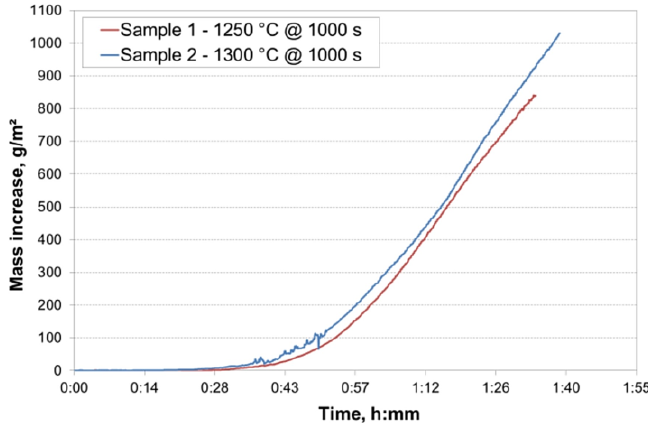
Figure 9. Increase in mass over time for oxidation at 1250 °C and 1300 °C in methane combustion atmosphere (reproduced from [19], with permission from the authors, 2014).